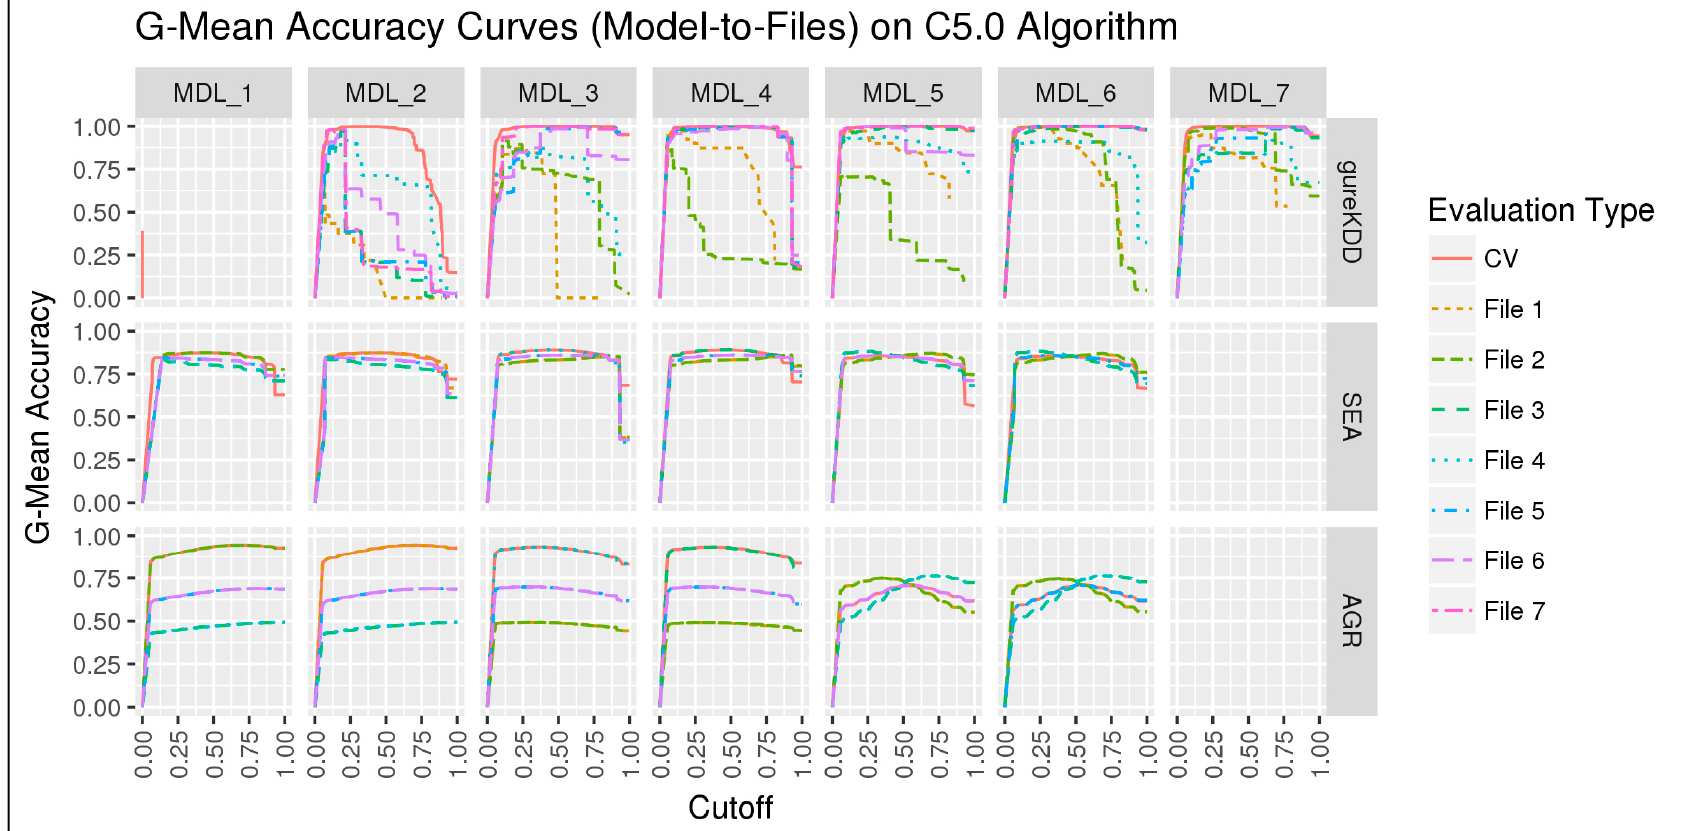
Figure A1. The gAcc curves for the C5.0 algorithm (see Table A1).